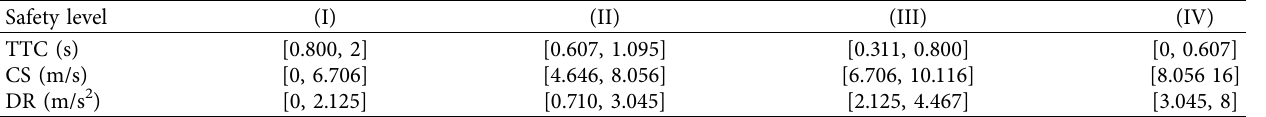
Table 1: Domain of the indicators.